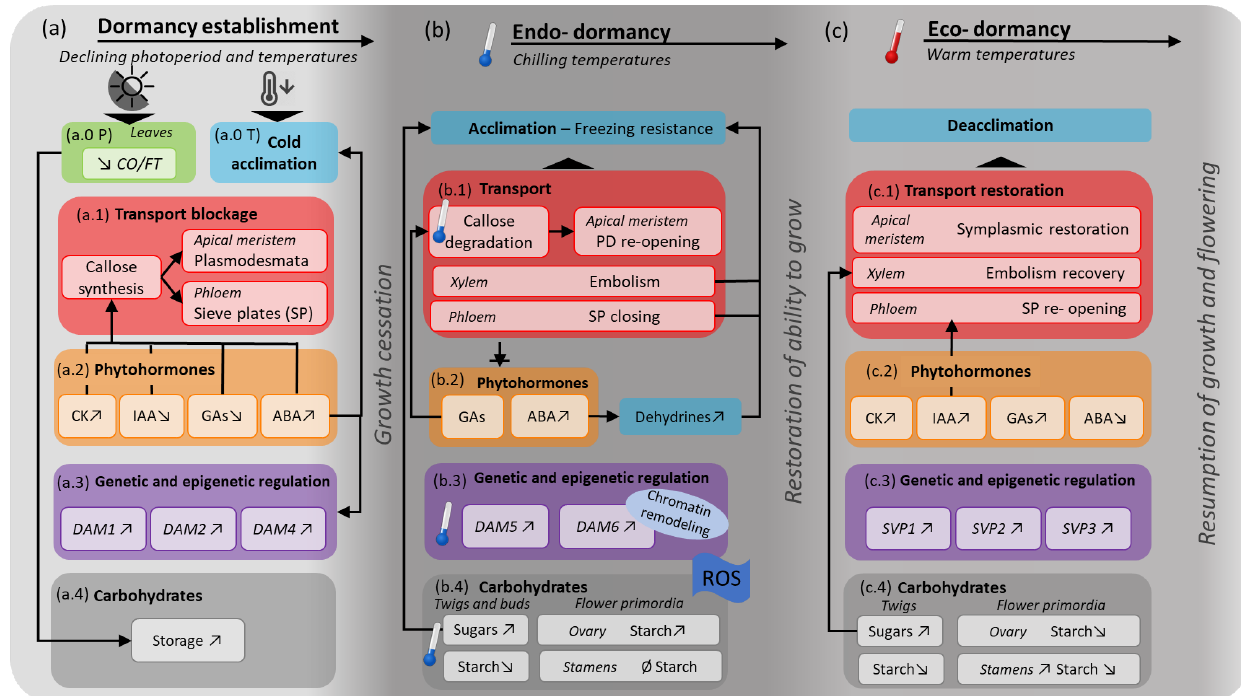
Figure 3. Conceptual framework of winter dormancy in deciduous trees. The dormancy framework (gray background) indicates three main phases: ( a ) dormancy establishment (light gray), ( b ) endo-dormancy (dark gray), and ( c ) eco-dormancy (medium gray). For each phase ( a , b , and c ), the dormancy-related physiological processes are represented by colored shapes and numbers (0 to 4). These processes are (0) the regulatory module CONSTANS (CO) / FLOWERING LOCUS T (FT) (green square), (1) the transport at both whole-plant (phloem and xylem) and meristematic/cellular (plasmodesmata—PD) level (red squares), (2) phytohormone dynamics (cytokinins—CK, auxins—IAA, gibberellins—GAs, and abscisic acid—ABA) (orange squares), (3) genetic and epigenetic regulation of the DORMANCY-ASSOCIATED MADS-box (DAM) genes and the SHORT VEGETATIVE PHASE (SVP) genes (purple squares), and (4) carbohydrate dynamics (gray squares). Within each colored square, the light squares indicate the concrete substance or process (plain text) and where it occurs (italics). ↗ indicates rising levels, ↘ decreasing levels, and Ø indicates absence. The shaded sun refers to declining photoperiod whereas the black thermometer stands for declining temperatures. The blue and red thermometers indicate that cold or warm temperatures, respectively, are directly associated with a given process. Black arrows establish a causal relationship between processes.